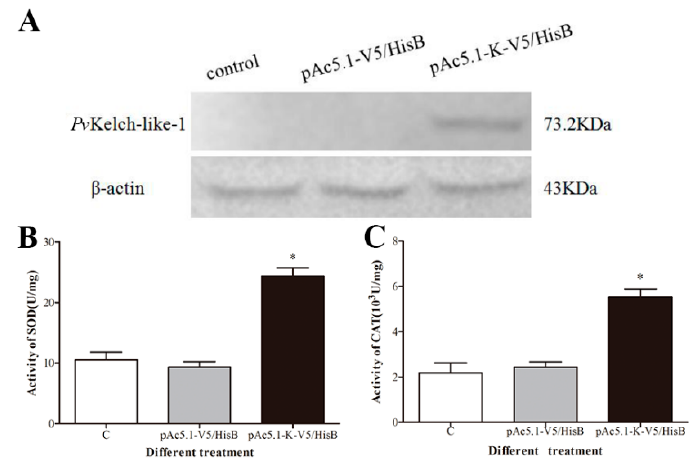
Figure 5. Effects of overexpression of Pv Kelch-like-1 on antioxidase activity. ( A ) Western blot detected Pv Kelch-like-1; ( B ) activity detection of SOD after overexpression of Pv Kelch-like-1; ( C ) activity detection of CAT after overexpression of Pv Kelch-like-1. Vertical bars represent the mean ± SD ( n = 3). Asterisks indicate statistically significant differences ( p < 0.05) between the three treatment groups.